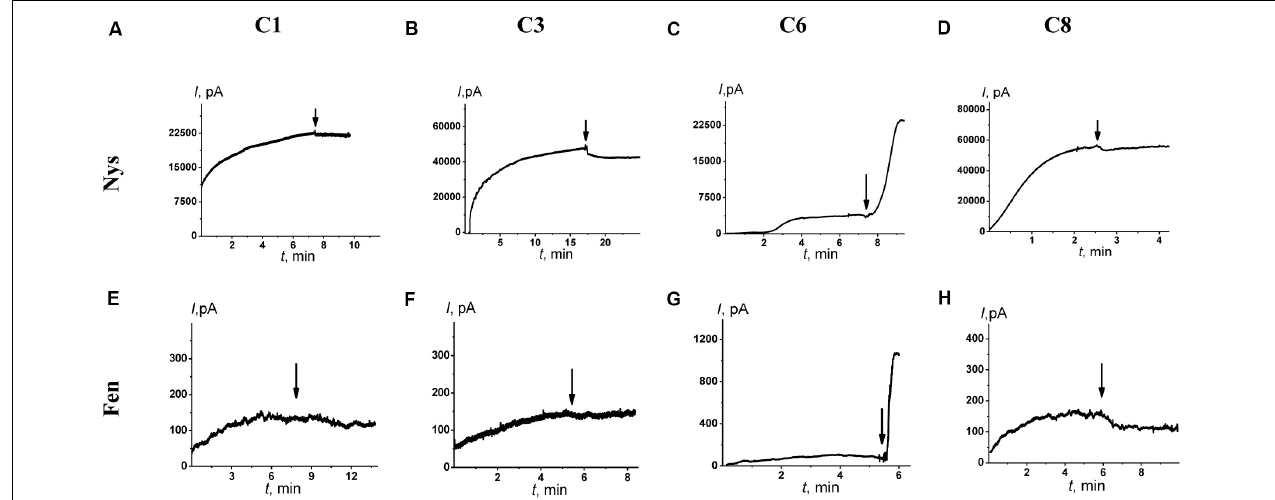
FIGURE 4 | Effects of 1,3-thiazine, 1,2,3,4-dithiadiazole, and thiohydrazide derivatives on the steady-state transmembrane current induced by 7–20 µ M Nys (upper panel) and 4–8 µ M Fen (lower panel). The moments for the addition of 100 µ M of C1 (A,E) , C3 (B,F) , C6 (C,G) , and C8 (D,H) to the bilayer-bathing solution are indicated by the arrows. The lipid bilayers were composed of DPhPC/CHOL (67/33 mol%) and bathed in 2.0 M KCl at pH 7.4 (upper panel) and POPC/POPE/POPG/ERG (20/20/50/10 mol%) and bathed in 2.0 M KCl at pH 9.0 (low panel). V = 50 mV.